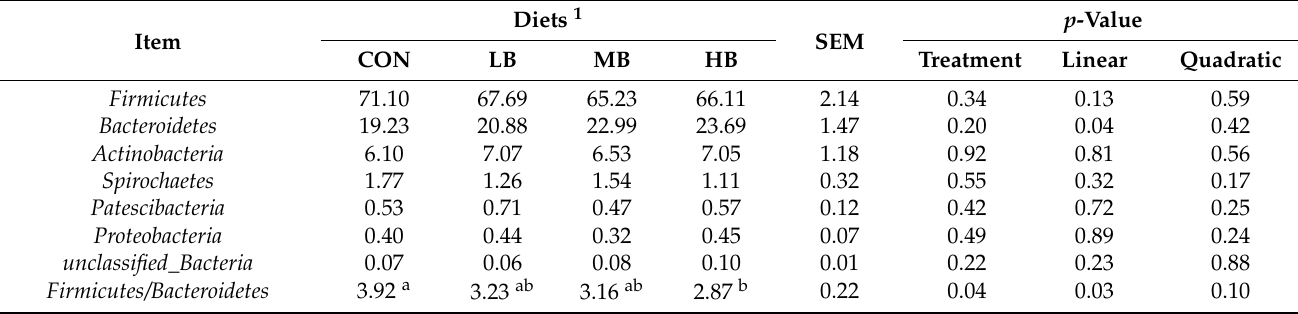
Table 3. The relative abundance of fecal bacterial phylum of lactating Holstein cows fed diets with by-products substituted for